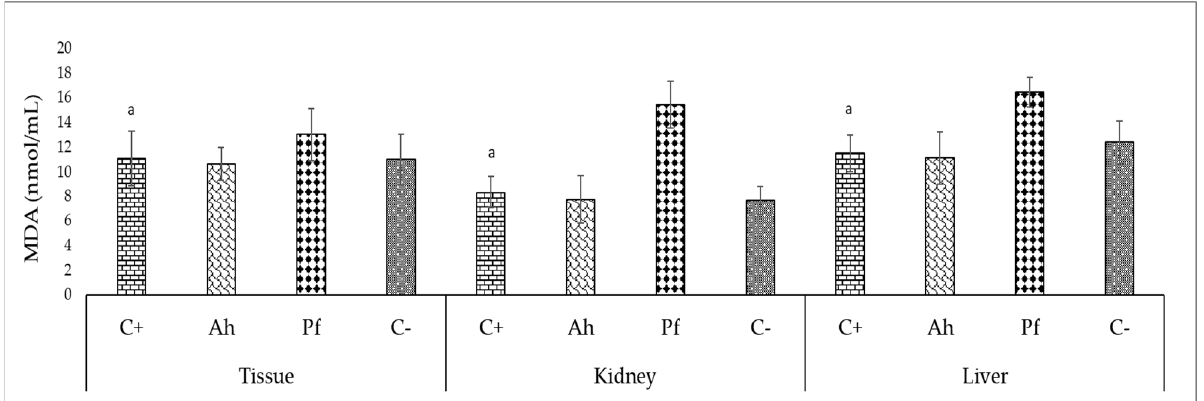
Figure 6. The level of oxidative stress biomarkers in the tissue, kidney, and liver of Nile tilapia, after a challenge test with Aeromonas hydrophila and Pseudomonas fluorescens . Results are shown as mean values and standard errors. (C + )—positive control; (Ah)— Aeromonas hydrophila ; (Pf)— Pseudomonas fluorescens ; (C − )—negative control. The letter ”a” means that there were no significant differences ( p >